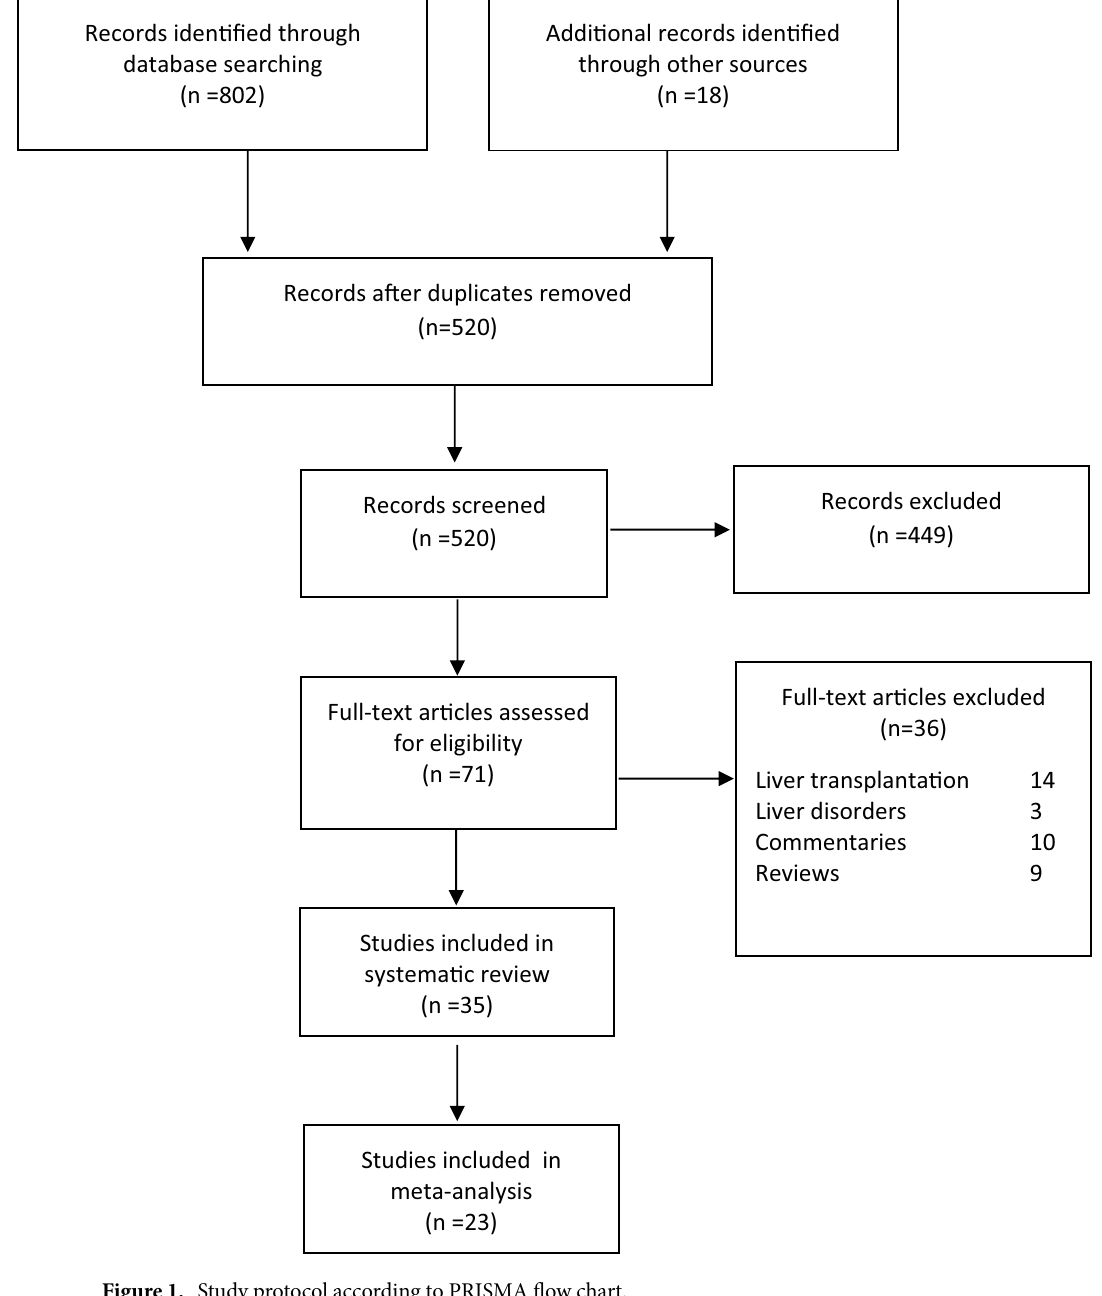
Figure 1. Study protocol according to PRISMA flow